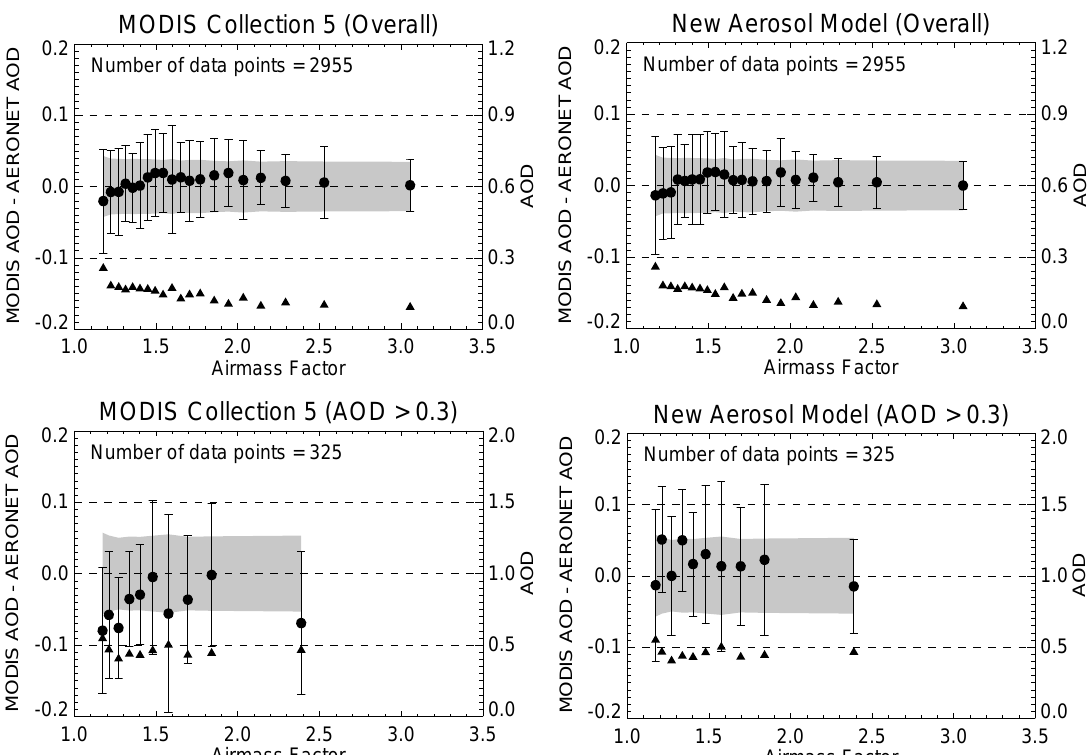
Fig. 11. Air-mass factor ( m Sun × m satellite , where m = sec[ θ ]) dependence of retrieval errors for the C005 algorithm (left) and the test algorithm (right) for overall data (upper) and data for AOD > 0.3